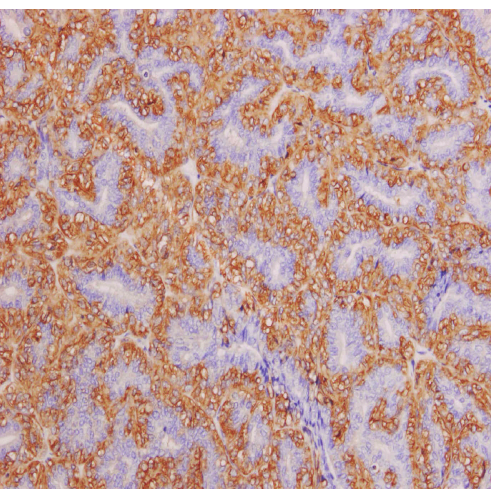
Figure 1: Benign adenomyoepithelioma part of the lesion stained with smooth muscle actin to show the myoepithelial component stained brown.